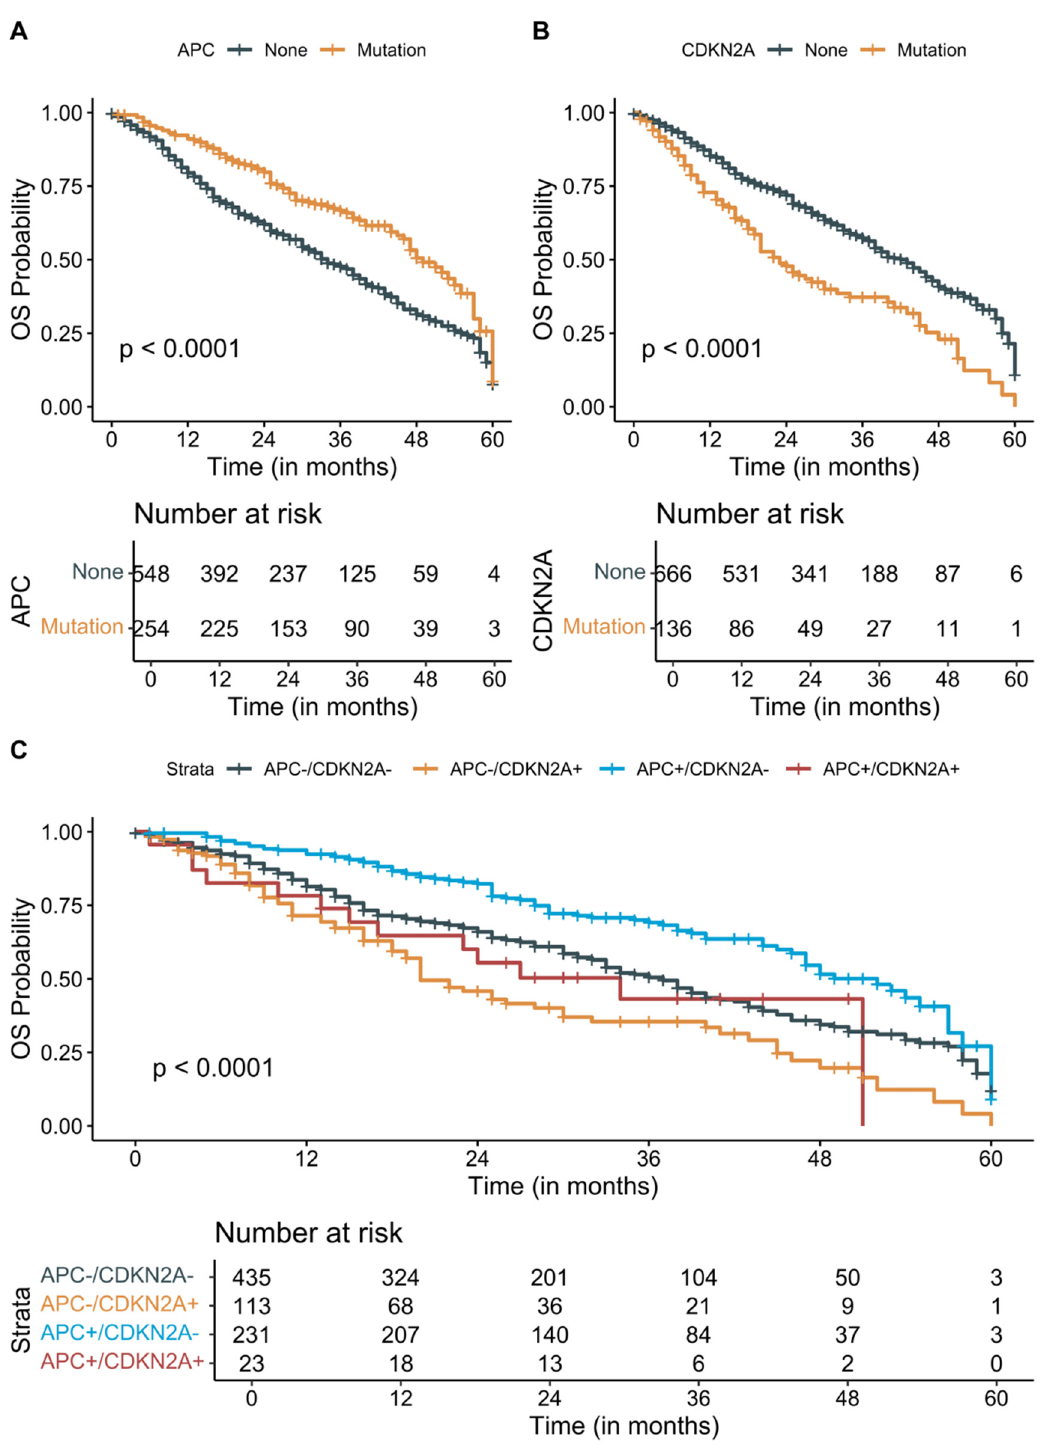
Figure 3. Patient survival analysis in the City of Hope Metastatic Dataset. Five-year Kaplan–Meier overall survival (OS) plots of patients with known ( A ) APC , ( B ) CDKN2A , and ( C ) both APC and CDKN2A mutations. Shorter OS was significantly associated with the presence of CDKN2A mutations, while APC mutations were significantly associated with longer OS. The OS benefit is observed in patients with APC and CDKN2A co-mutation compared to CDKN2A mutations only.